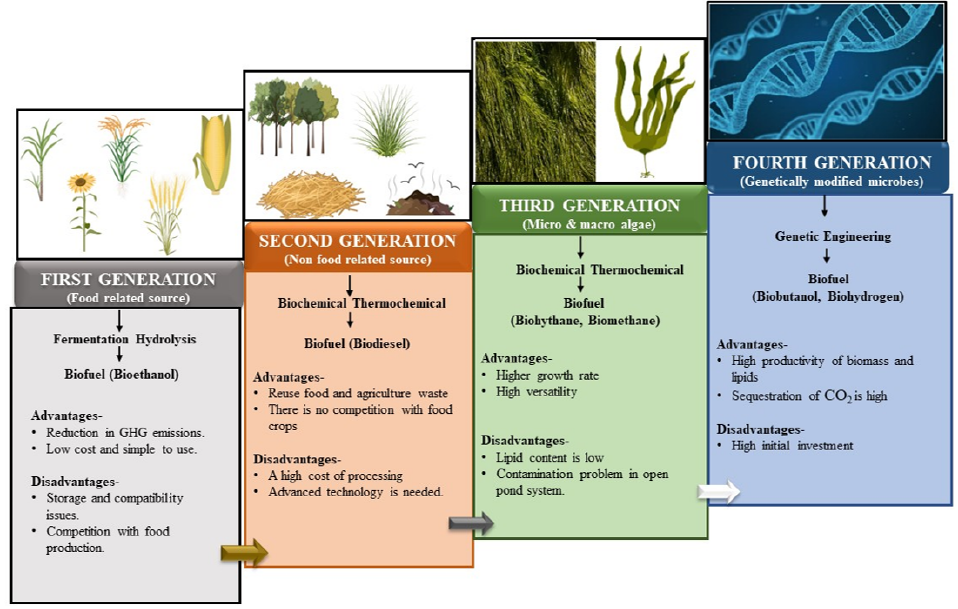
Figure 1. A schematic representation of the evolution of biofuels production.